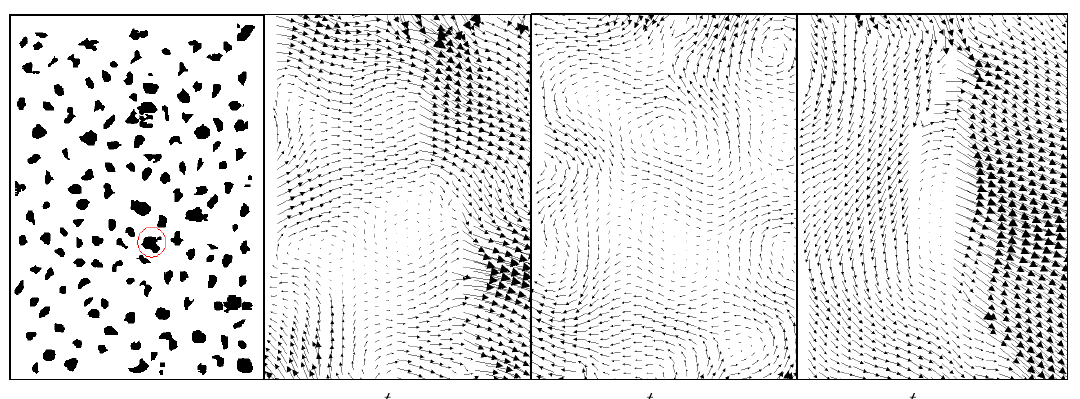
Figure 10: Simulation shift-fields for the composite with 15% content of the hardening particles in the case of friction on the loading border.